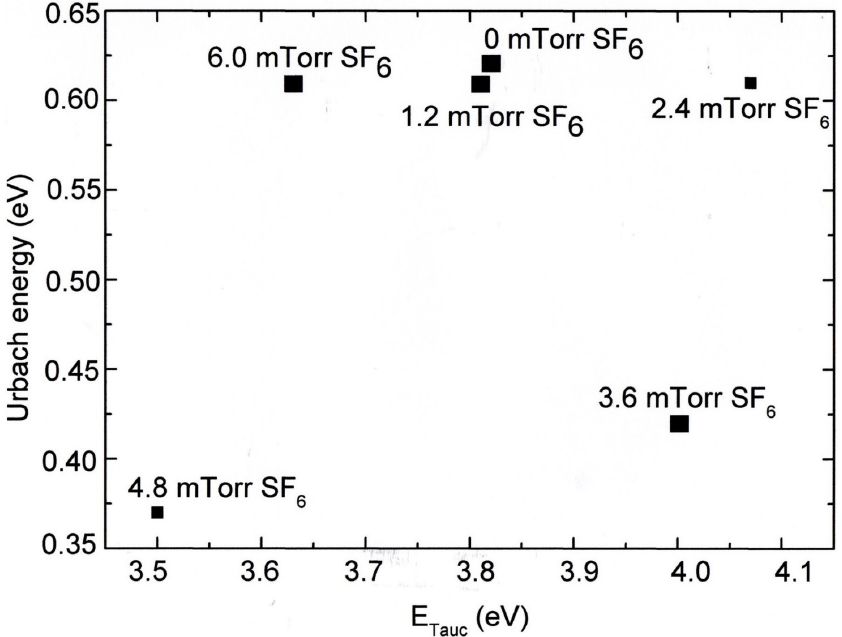
used for each film deposition is 6